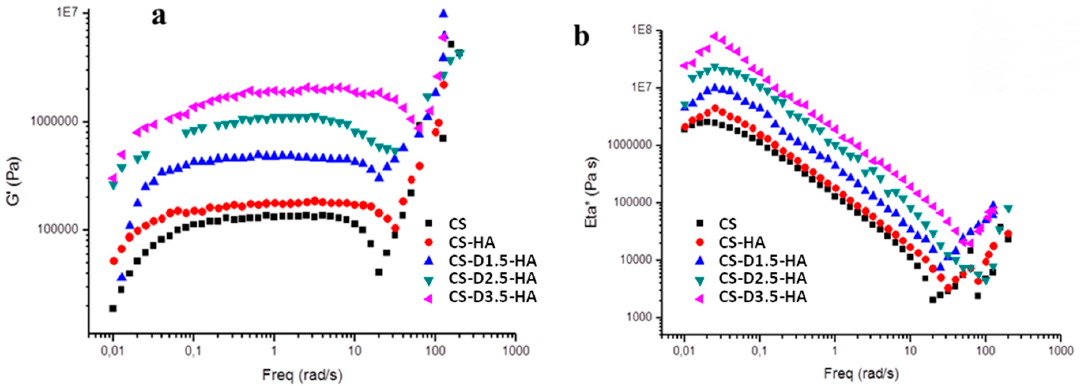
Figure 8. Elastic G’ modulus ( a ) and complex viscosity (Eta*) ( b ) vs. frequency for CS, CS-HA, CS-